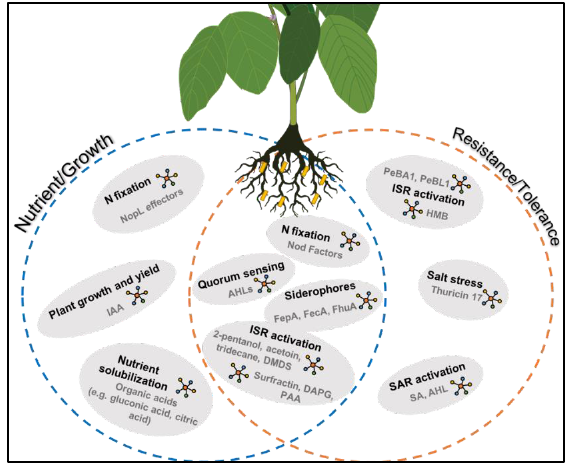
Figure 1. Schematic representation of the main processes and relevant molecules underlying plant growth promotion by bacteria. Abbreviations: AHL = N-acyl homoserine lactone; DAPG = 2,4-diacetylphloroglucinol; DMDS = dimethyl disulfide; HMB = 3-hydroxy-5-methoxy benzene methanol; IAA = indole-3-aceticacid; ISR = inducedsystemicresistance; N = nitrogen; Nod = nodulation; PAA = phenylacetic acid; SA = salicylic